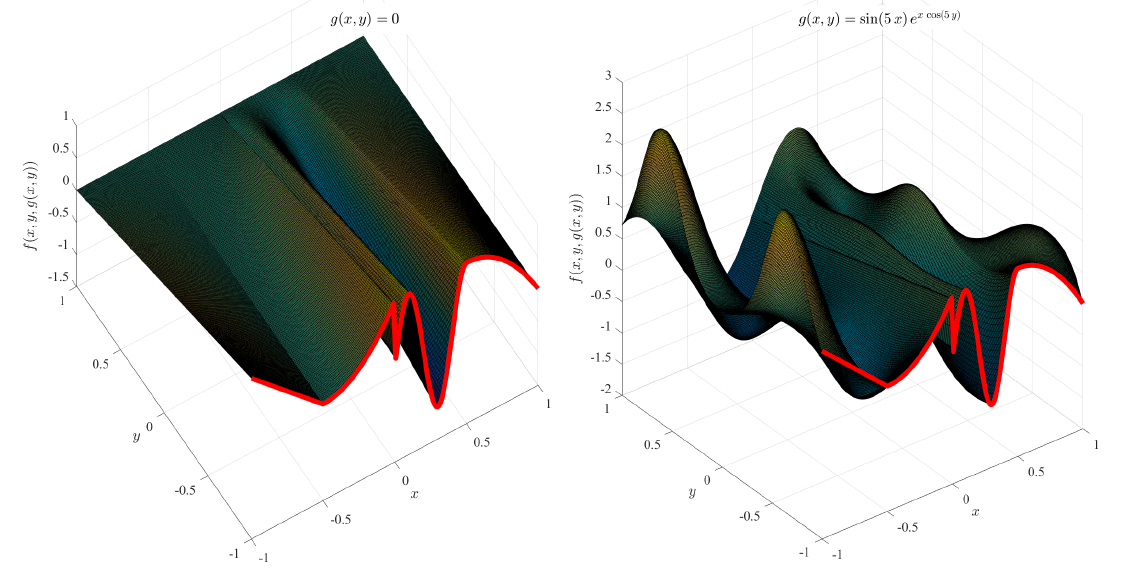
Figure 6. TFC surface examples obtained with g ( x ) = 0 ( left ) and g ( x ) = sin ( 5 x ) e x cos ( 5 x ) ( right